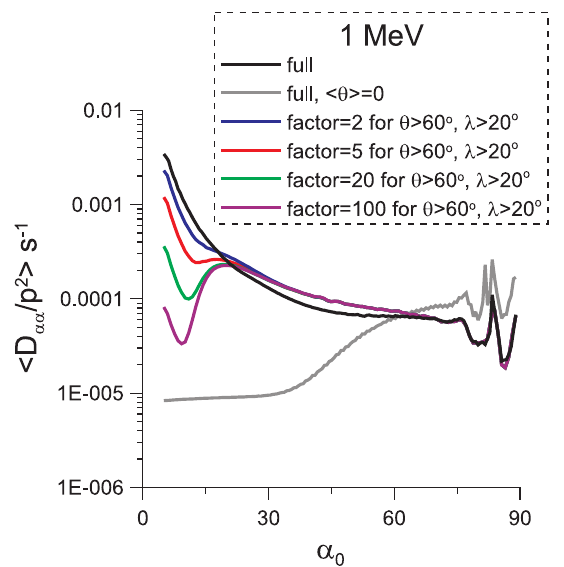
Fig. 16. Comparison of bounce-averaged pitch-angle diffusion co- efficients for (cid:127) pe /(cid:127) c0 = 4 . 5 and 1MeV electrons, obtained for dif- ferent reduced levels of oblique chorus wave intensity at λ > 20 ◦ .